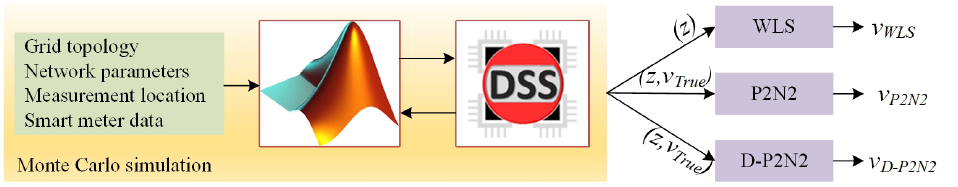
Figure 8. The simulation and model evaluation